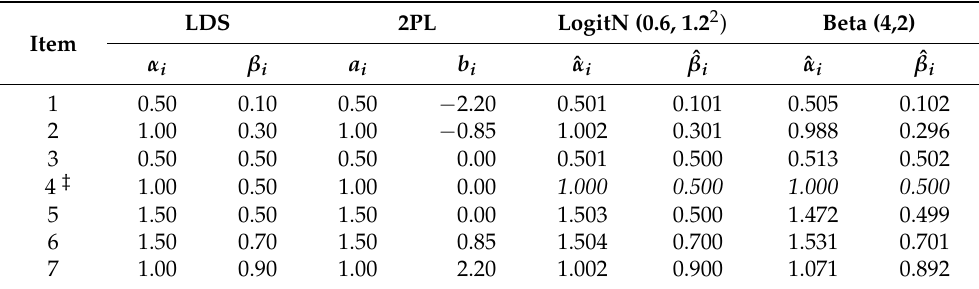
Table 1. Estimated item parameters for the numerical illustration assuming a logit-normal distribu- tion and a beta